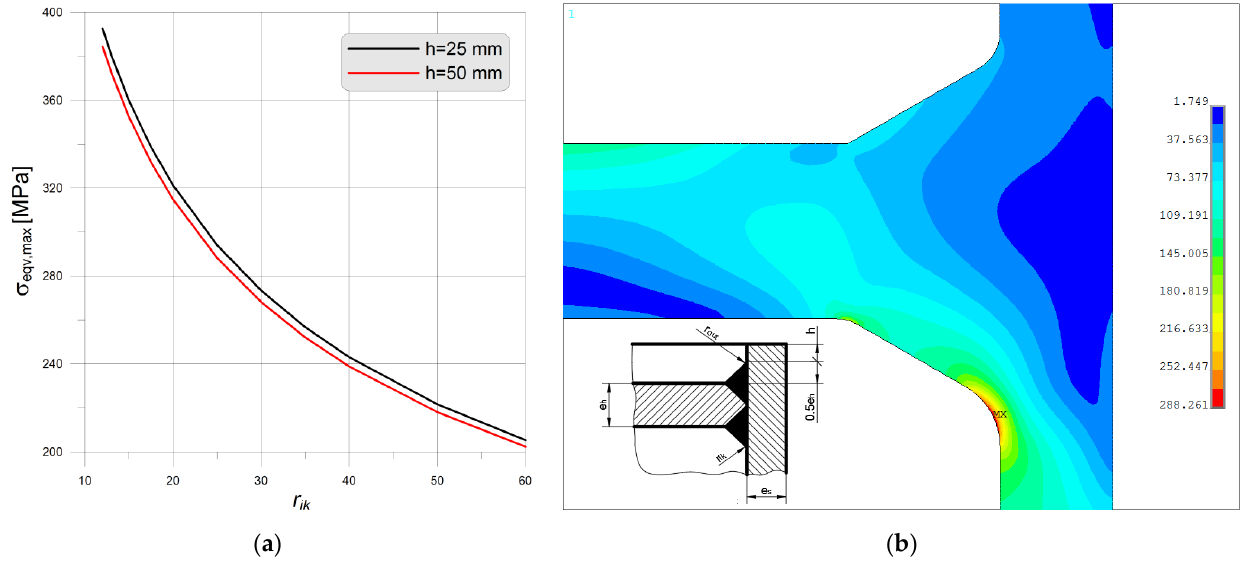
Figure 26. Bottom type “h”, pipe Ø406.4 × 40 mm: ( a ) maximum equivalent stress in function of r ik ( b ) equivalent stress distribution for h = 50 mm and r ik = 25 mm.